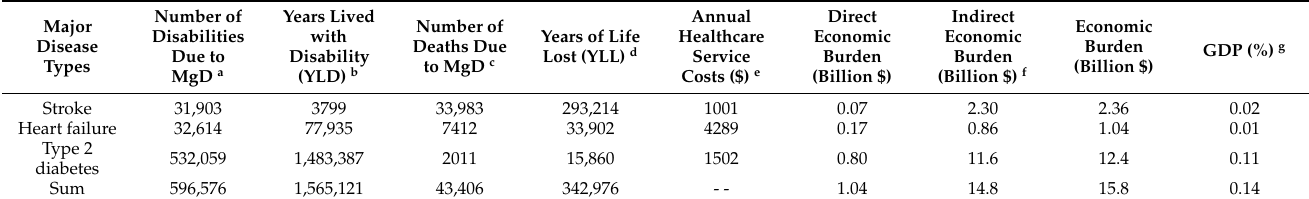
Table 2. Health and economic burden of Mg malnutrition, a case study in China.